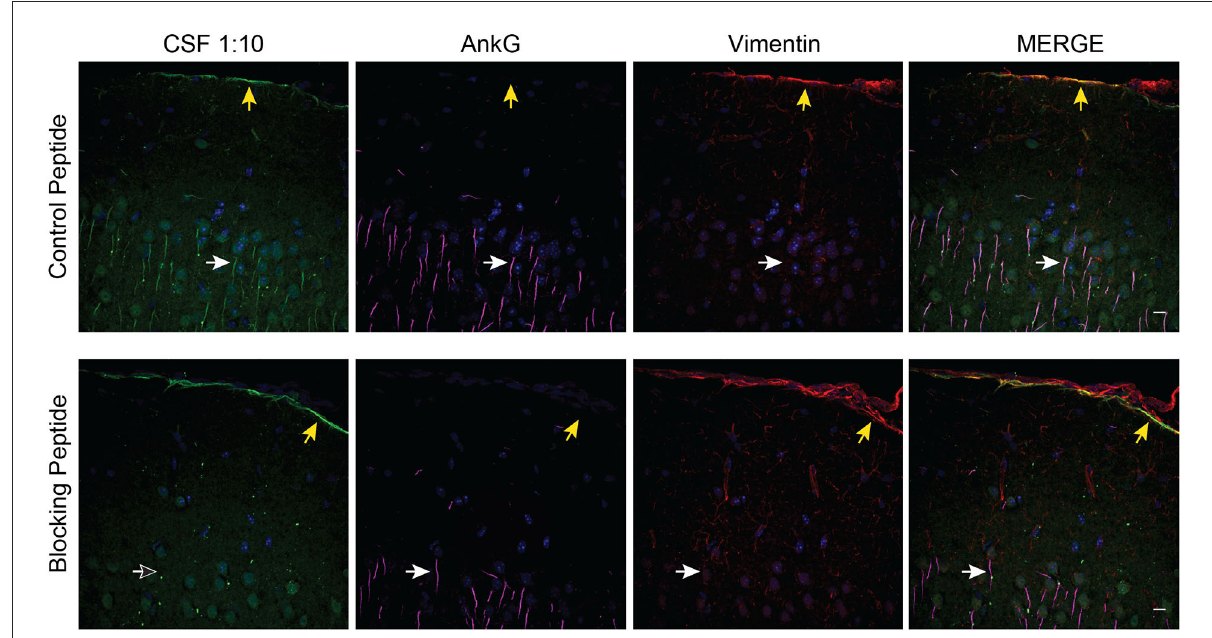
FIGURE4 Identification of a subpial autoantibody. Case 1 CSF TBIF of murine cortex with control or blocking peptide. Tissue was co-stained with AnkG (magenta) and Vimentin (red) to identify the overlying pial tissue. Yellow arrows point to subpial CSF IgG. White arrows point to an AIS. The empty arrow in the lower left panel indicates the absence of AIS immunostaining. Scale bar = 10 µ